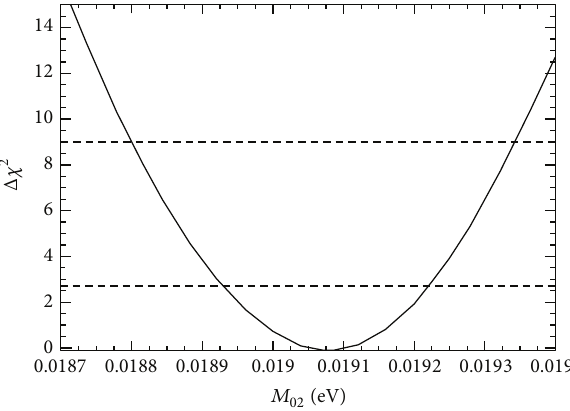
Figure 10: Dependence of 𝜒 2 on the free parameter 𝑀 02 . Dotted lines indicate 90 % and 99.73 % confidence